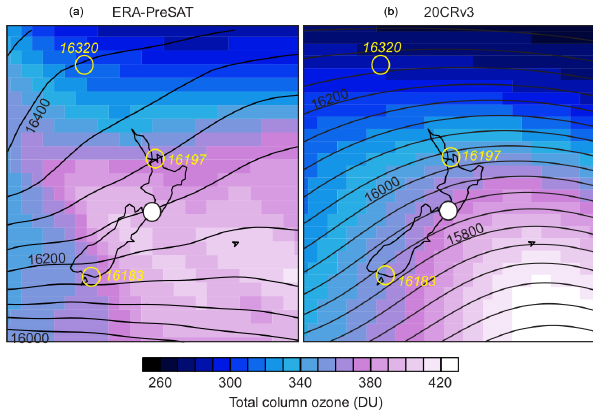
Figure 6. Total column ozone and 100hPa geopotential height on 25 September 1952 in ERA-PreSAT (a) and 20CRv3 (b) . The filled circle indicates the measured total column ozone value at Welling- ton (434.6DU, adjusted coefficients); open circles indicate geopo- tential height from radiosonde (taken 12h